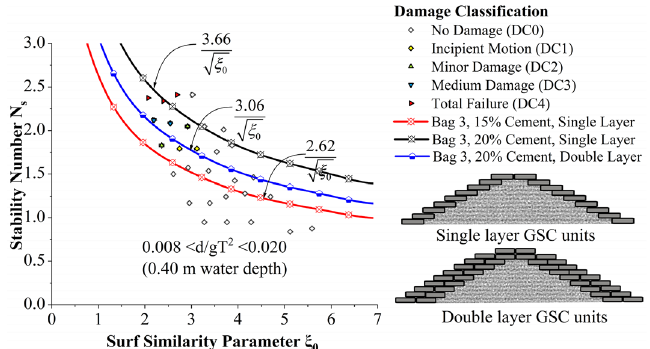
Figure 14. Stability curves of all experimented configurations for a relative water depth of 0.008 < d/gT 2 < 0.020 (0.40 m actual water depth in flume).